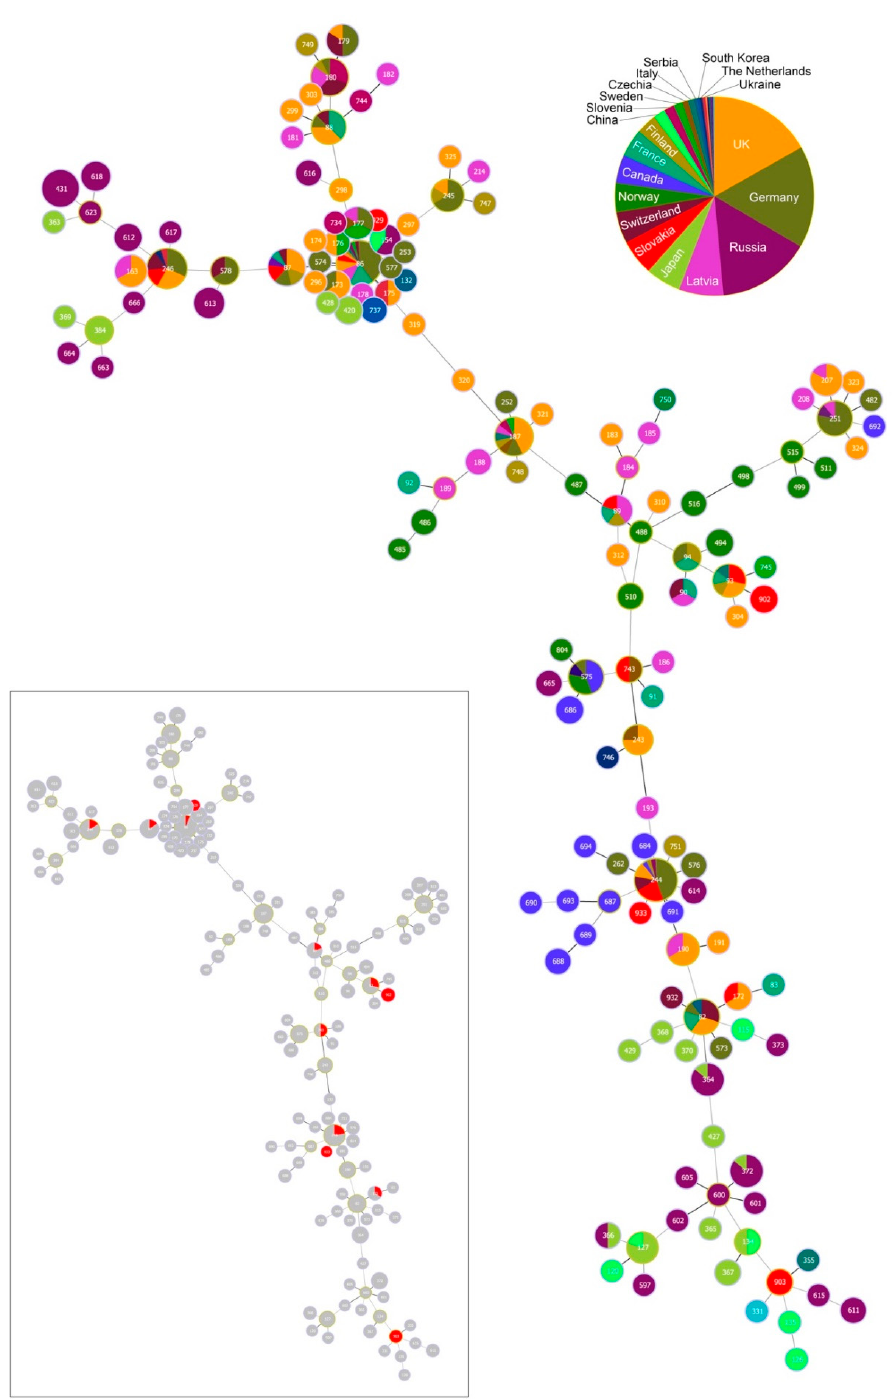
Figure 5. Minimum-spanning tree of Borrelia garinii multi-locus sequence types (STs). The tree was constructed for 147 STs deposited in the PubMLST database by the goeBURST Full MST algorithm with PhyloViz 2. The tree was constructed at the maximum level of locus variants (level 8). ST nodes representing inferred CC founders are outlined in light-green color. Node size reflects the number of isolates for the ST. The links having less differences between nodes are shown by darker grey color compared to links between more di ff erent nodes. Di ff erent colors and their area within nodes reflect country and the number of isolates for the given ST and country. The tree miniature highlights STs detected in Slovakia (red